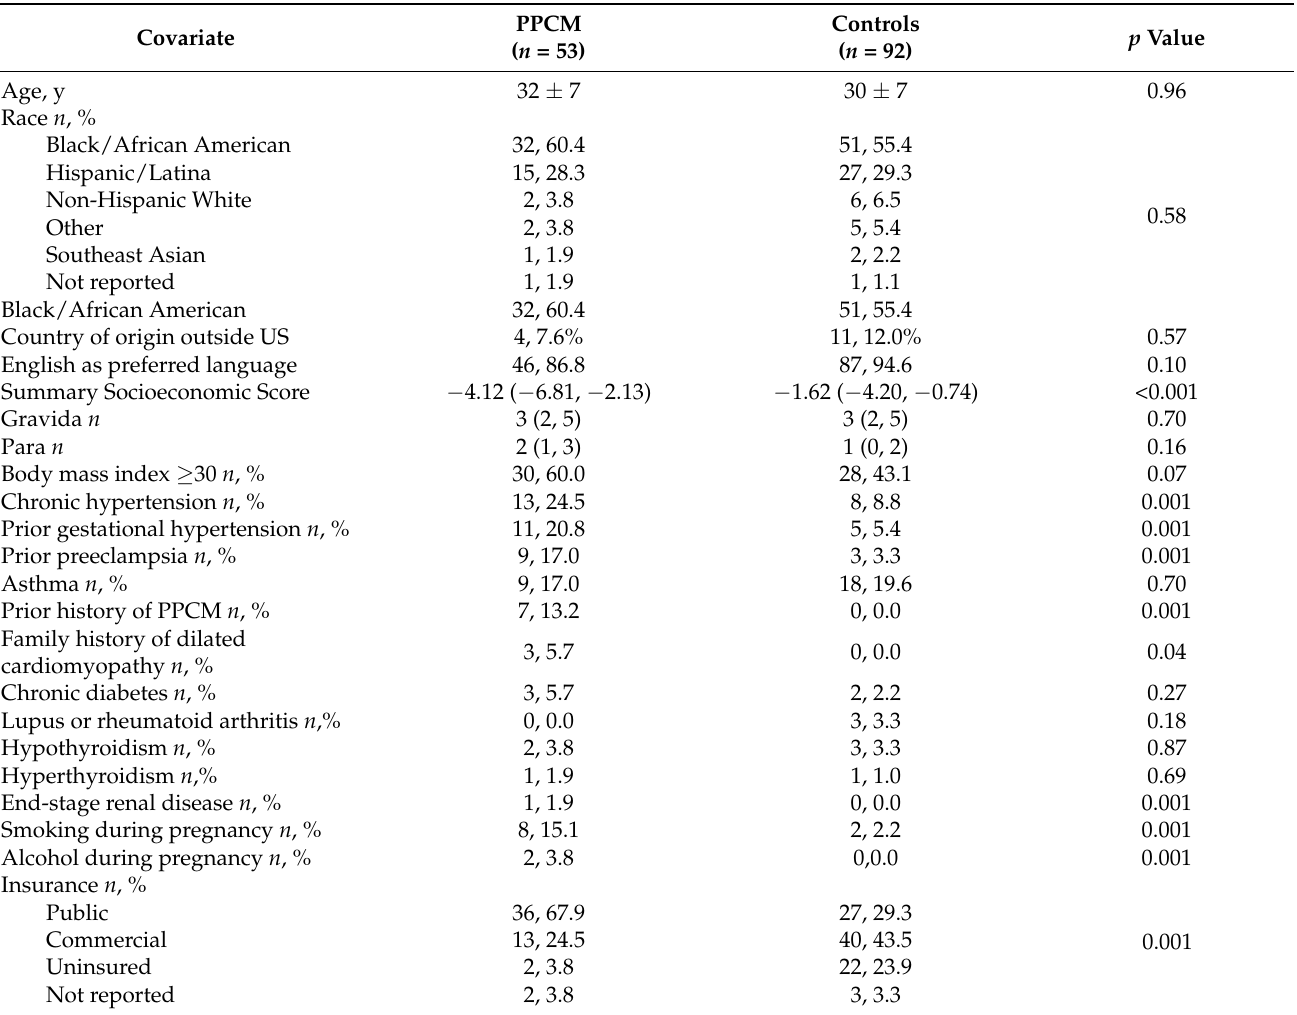
Table 1. Baseline characteristics of women with peripartum cardiomyopathy ( n = 53) vs. age